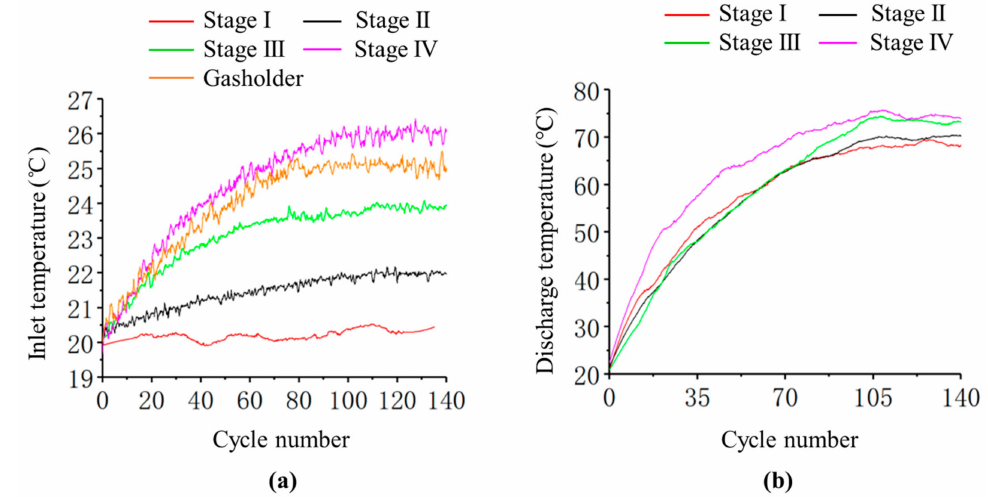
Figure 17. ( a ) Inlet and ( b ) discharge temperatures in all stages.